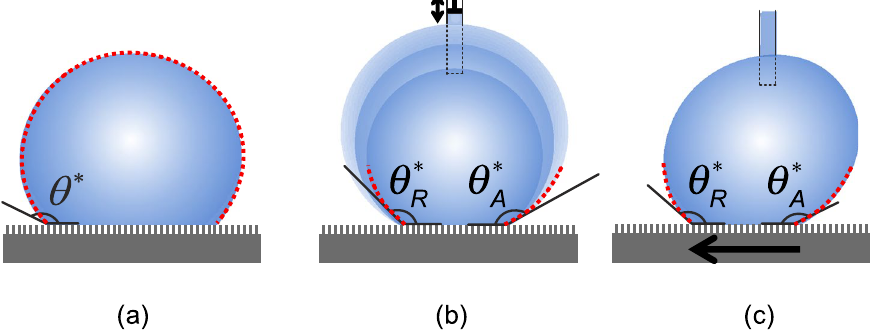
Figure 1. General methods of contact angles measurement, shown on super-repellent surfaces. ( a ) Static contact angle of a symmetric droplet can be measured by fitting the global droplet profile with a theoretical profile calculated from Young-Laplace equation. ( b ) Dynamic contact angles revealed by adding and subtracting the liquid to the droplet through a syringe needle, which tends to compromise the droplet symmetry in practice. ( c ) Dynamic contact angles revealed by sliding the droplet, which destroys the droplet symmetry. For ( b ) and ( c ), which lack the droplet symmetry, dynamic contact angles are usually measured by fitting the local droplet profile near the contact point with a polynomial